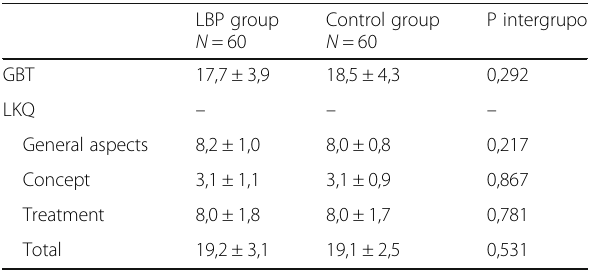
Table 3 Scores of the Gestural Behavior Test (GBT) and Low Back Pain Knowledge Questionnaire